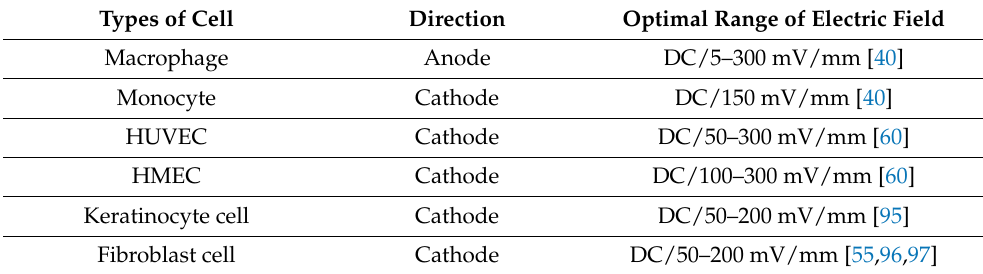
Table 2. Galvanotaxis direction of cells and their optimal range of electric